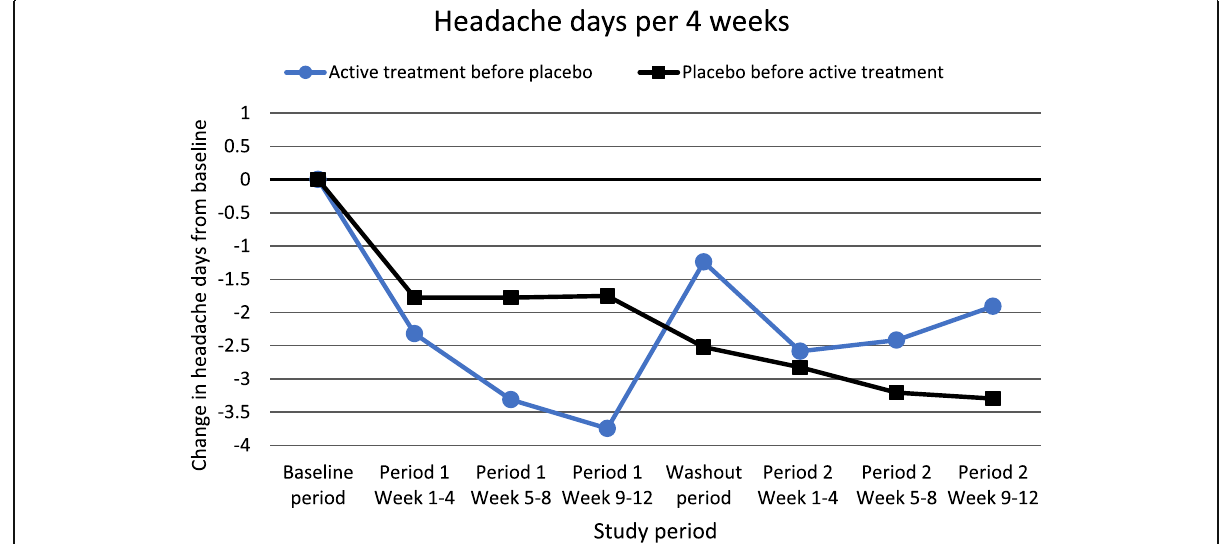
Fig. 2 Headache days per 4 weeks in relation to treatment sequence (square: Placebo first, n = 80; circle: Active treatment first, n = 96). Data from the study published in 2015 (the ALCAR-study) were omitted from this analysis due to lack of efficacy vs.